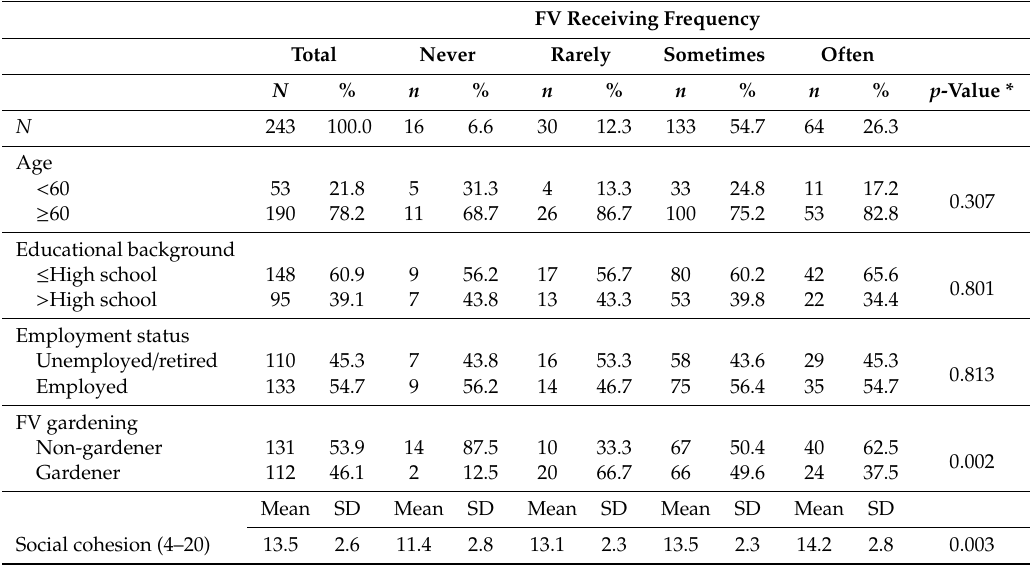
Table A1. Participants’ characteristics according to FV receiving frequency (Survey